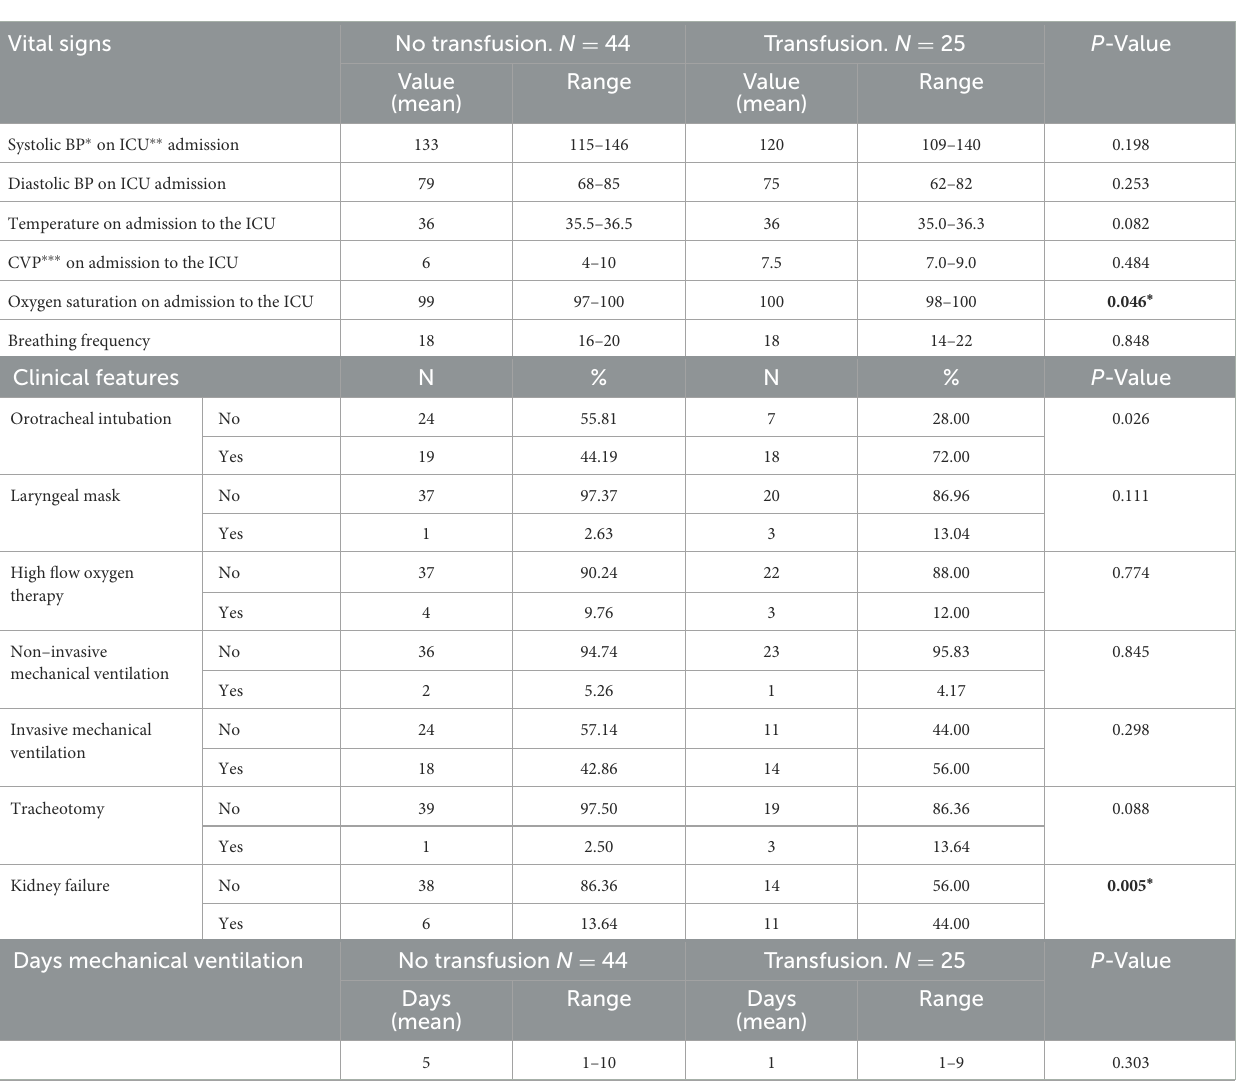
TABLE 2 Clinical